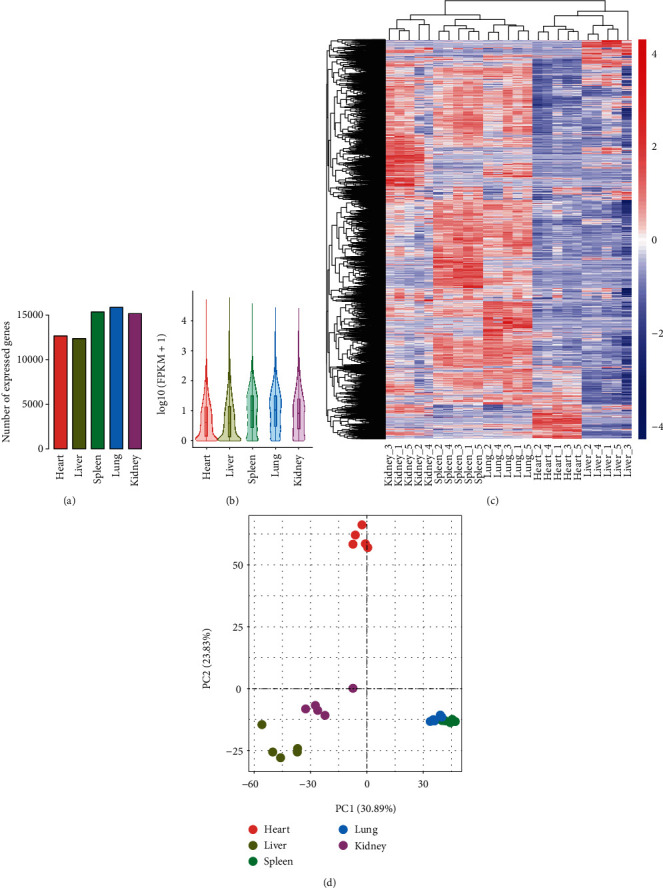
Overview of all genes expressed level in the giant panda. (a) Statistical histogram of the number of genes expressed in each tissue using the R language function barplot. (b) Violin plot generated by the ggplot2 R package based on FPKM value of all genes in each tissue. The ordinate represents log10(FPKM+1). Each region of violin plot corresponds to five statistics (top-down, maximum, upper quartile, median, lower quartile, and minimum). The width of each violin represents the number of genes under that expression. (c) Hierarchical clustering heatmap of all expressed genes based on the normalized FPKM values. It generated by the pheatmap R package and the red-blue spectrum represents the normalized FPKM values. (d) Principal component analysis based on the FPKM value of all expressed genes using the ggplot2 R package.